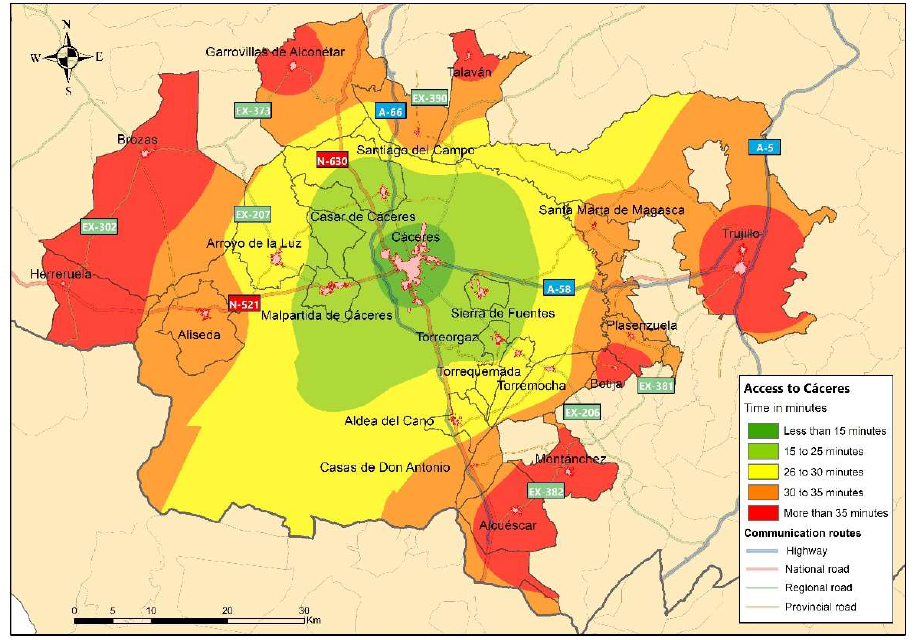
Figure 4. Territorial accessibility to the city of Cáceres.